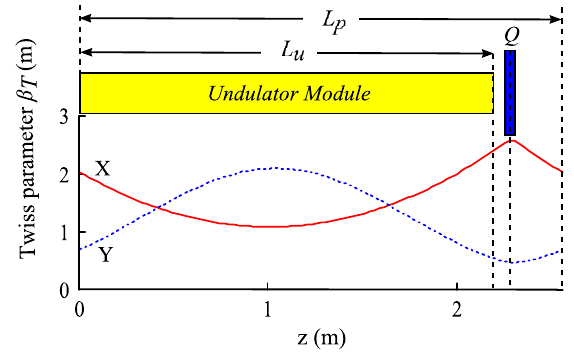
FIG. 10. Calculated evolution of the (cid:5) (cid:5) (dotted blue) Twiss coefficients in the periodic FODO of y ¼ 256 cm composed by an undulator section of length length L p ¼ 215 : 6 cm and a quadrupole ( Q ) in the drift between two L u adjacent modules.